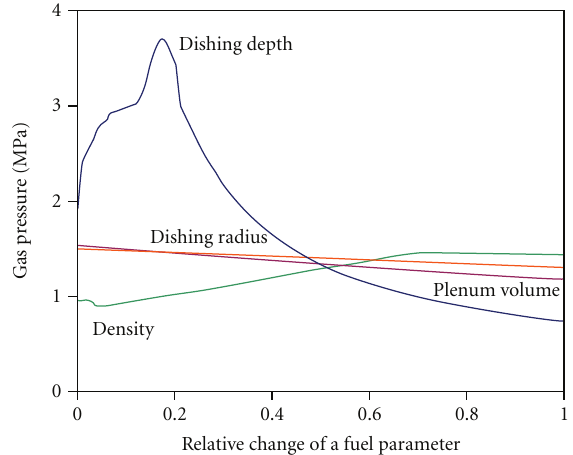
Figure 8: Gas pressure parametric analysis. Analyze of the relative influence of fuel parameters during the first reshu ffl ing of a fuel element irradiated in the Atucha I NPP.